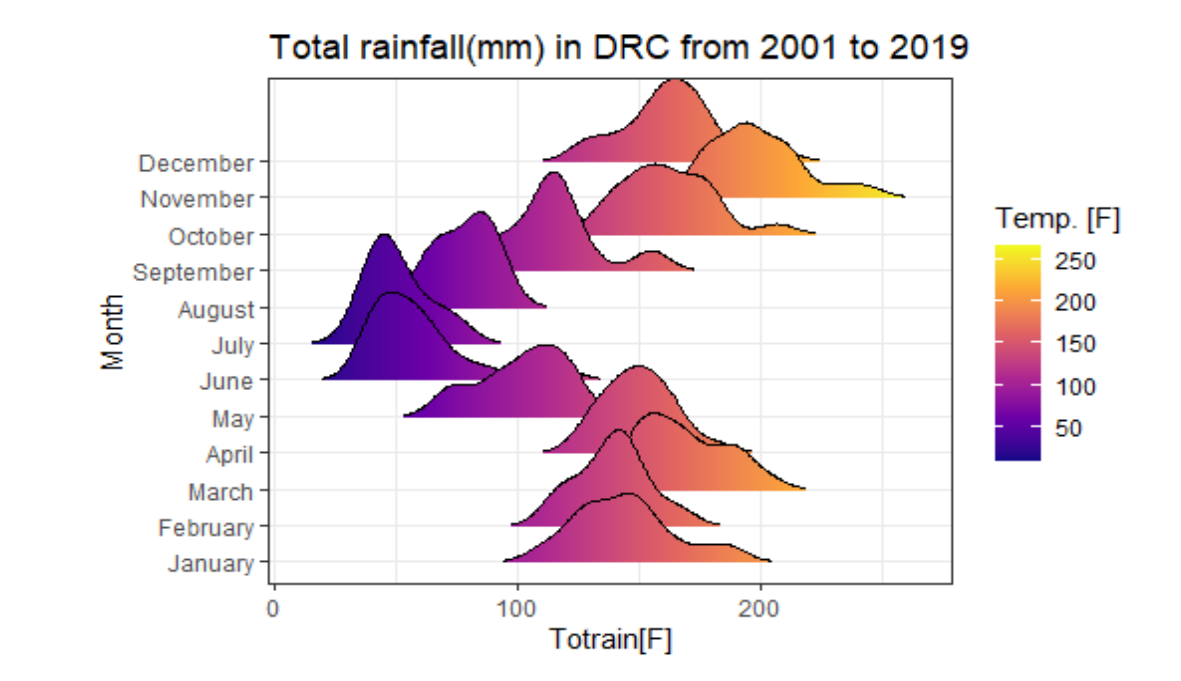
Figure A8. Min temperature (°C) in DRC from 2001 to 2019.